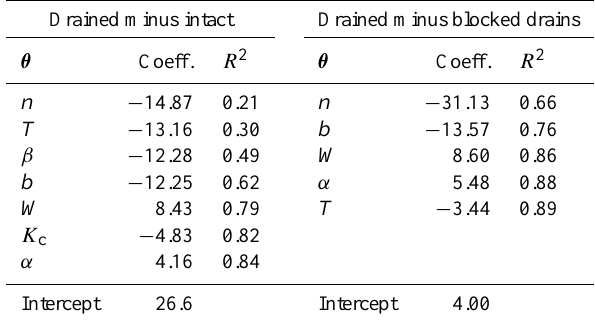
Table 4. Regression models to predict 1q d − i ( r ) and 1q d − b ( r ) . The parameters and their regression coefficients are shown in in- creasing order of significance. R 2 -values are cumulative, demon- strating the effect of progressive addition of parameters.